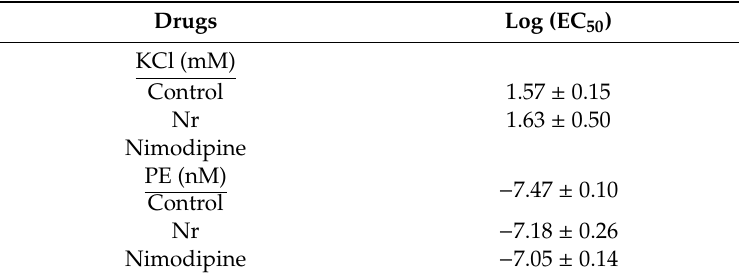
Table 2. E ff ect of N. ramosissima (Nr.; 100 µ g / mL) on the contractile response to KCl (10–60 mM),